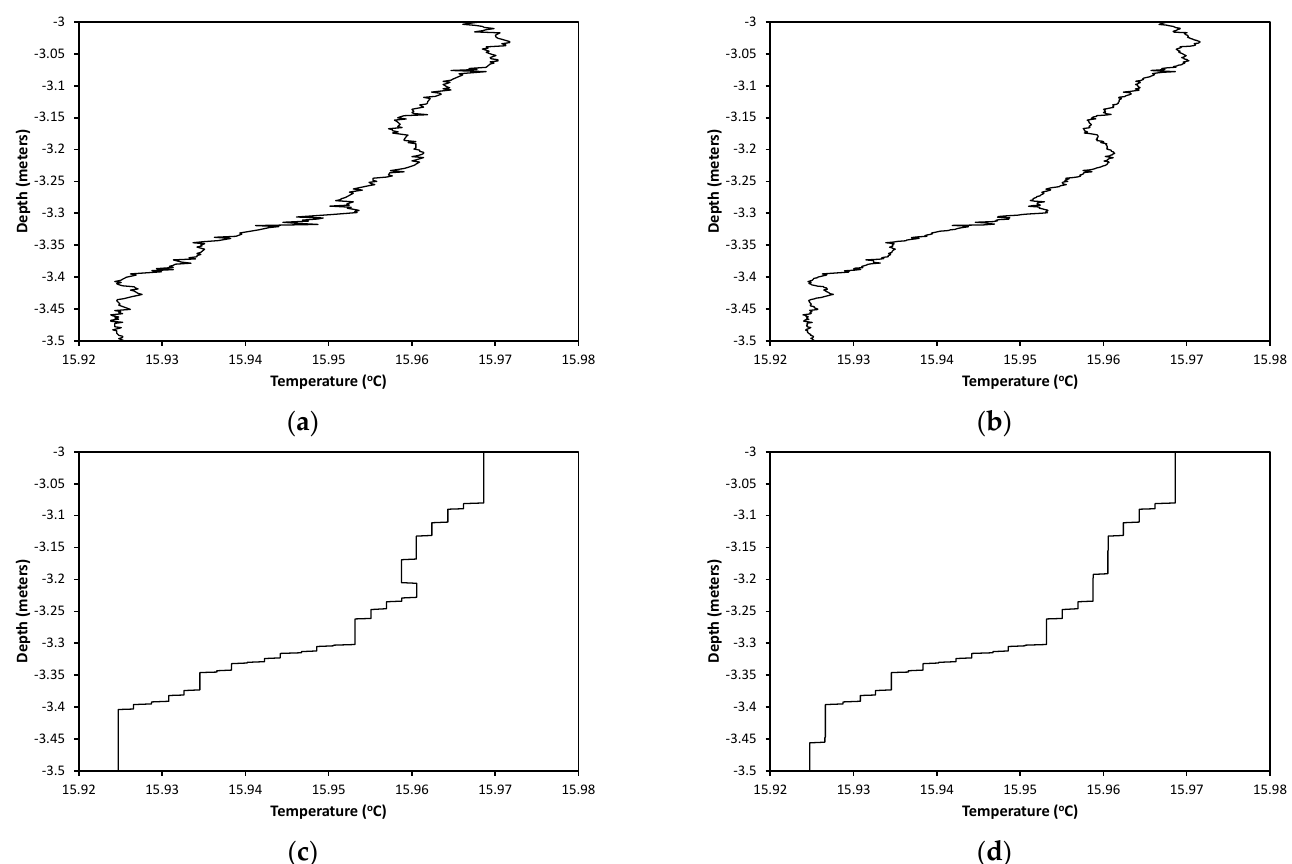
Figure 2. Examples of profile segments illustrating the effects of interpolation to 1 mm vertical spatial resolution and temperature resolution of 3.5 × 10 − 3 °C: ( a ) raw profile; ( b ) spatially interpolated profile; ( c ) spatially and temperature interpolated profile; ( d ) Thorpe-ordered version of ( c ). Profile recorded in Blelham Tarn at 11:00 on 11 August 2008).